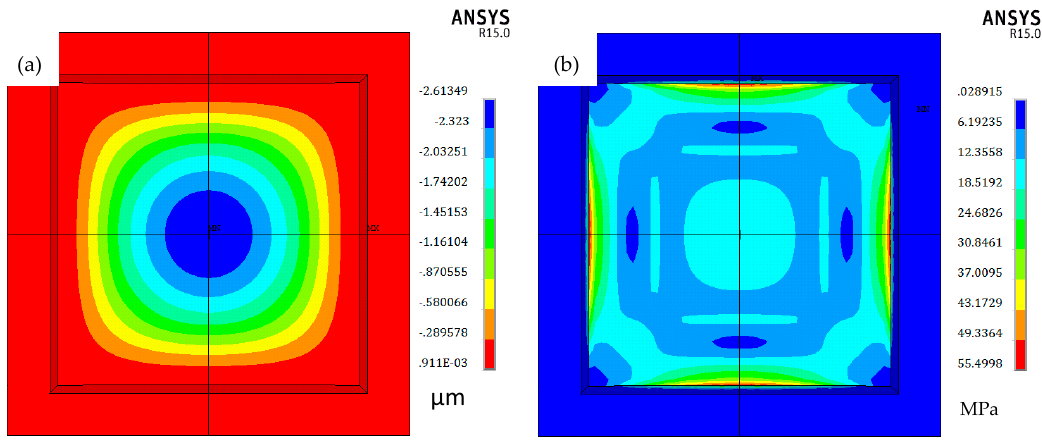
Figure 3. ANSYS simulation of diaphragm when p = 0.1 MPa. ( a ) Deflection; ( b ) Von Mises stress.